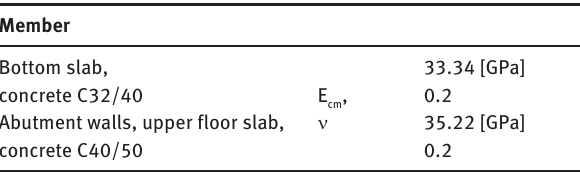
Table 4. Concrete modulus of elasticity and Poisson’s ratios [11]. Member Bottom slab,